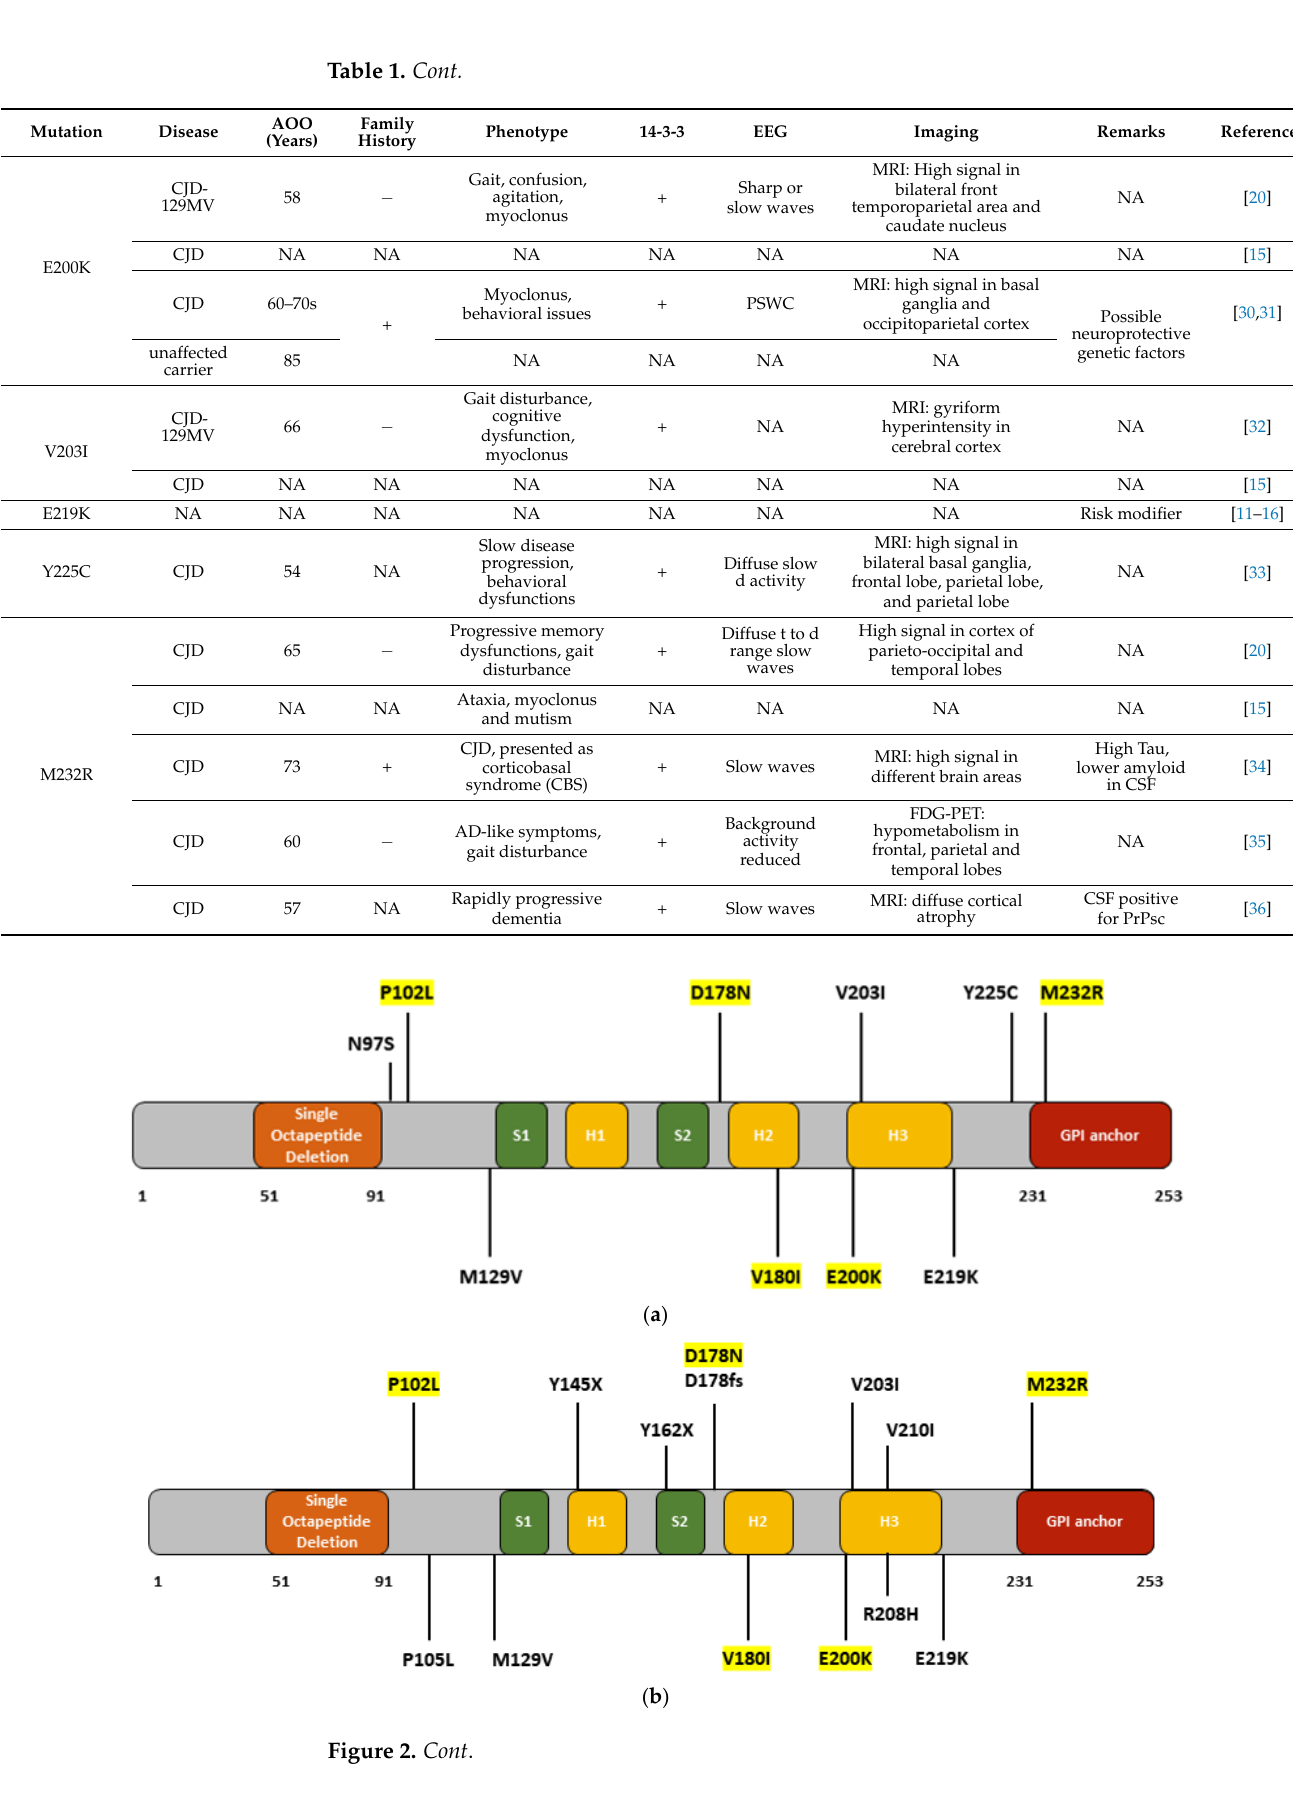
Longest CJD survivor